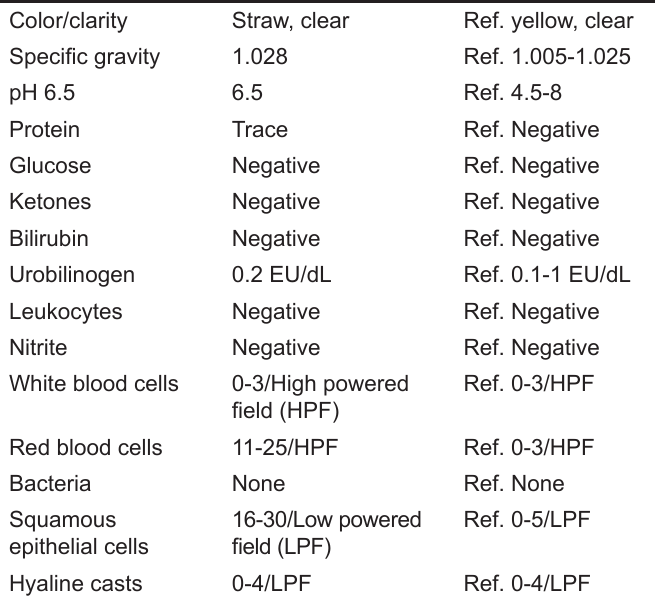
Table 3. Urinalysis results